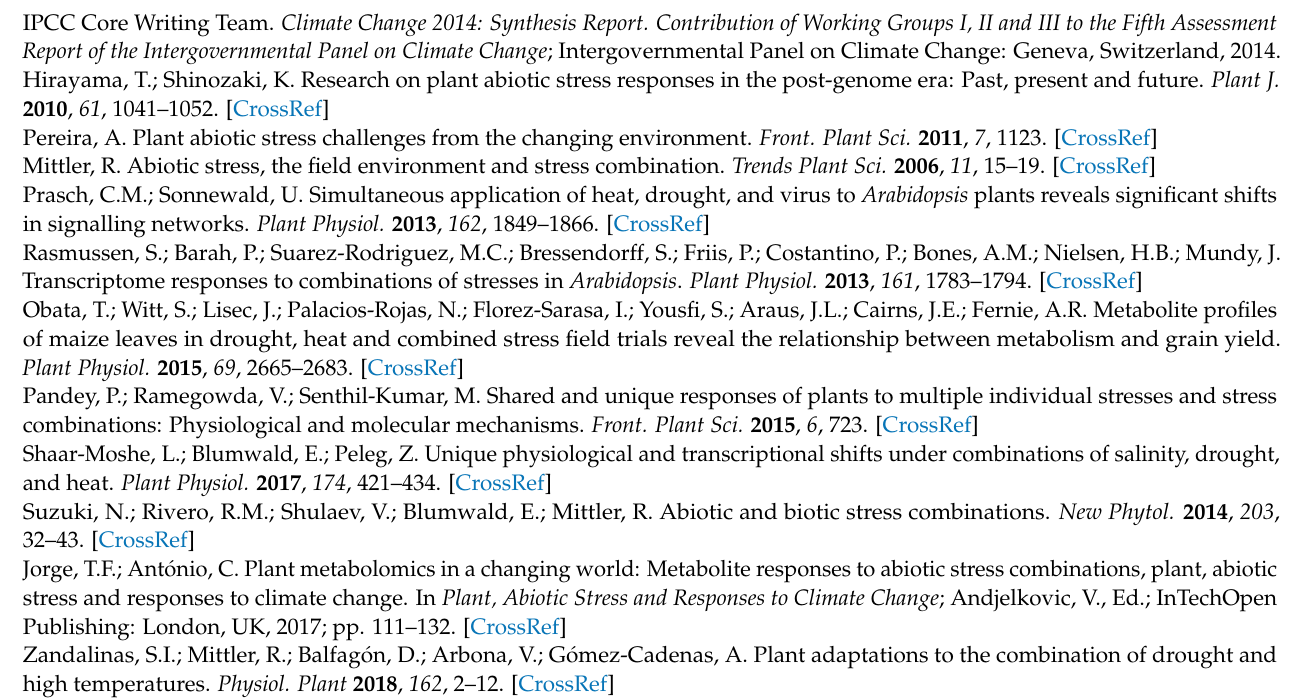
Table S5 metabolomics metadata infor-mation, Methods S1 detailed description of the chlorophyll a parameters evaluated under pho-tosynthetic steady-state conditions, Methods S2 lipid analyses, Methods S3 primary metabolite extraction, derivatisation and GC-TOF-MS analysis, Methods S4 secondary metabolite extraction and LC-HRMS analysis